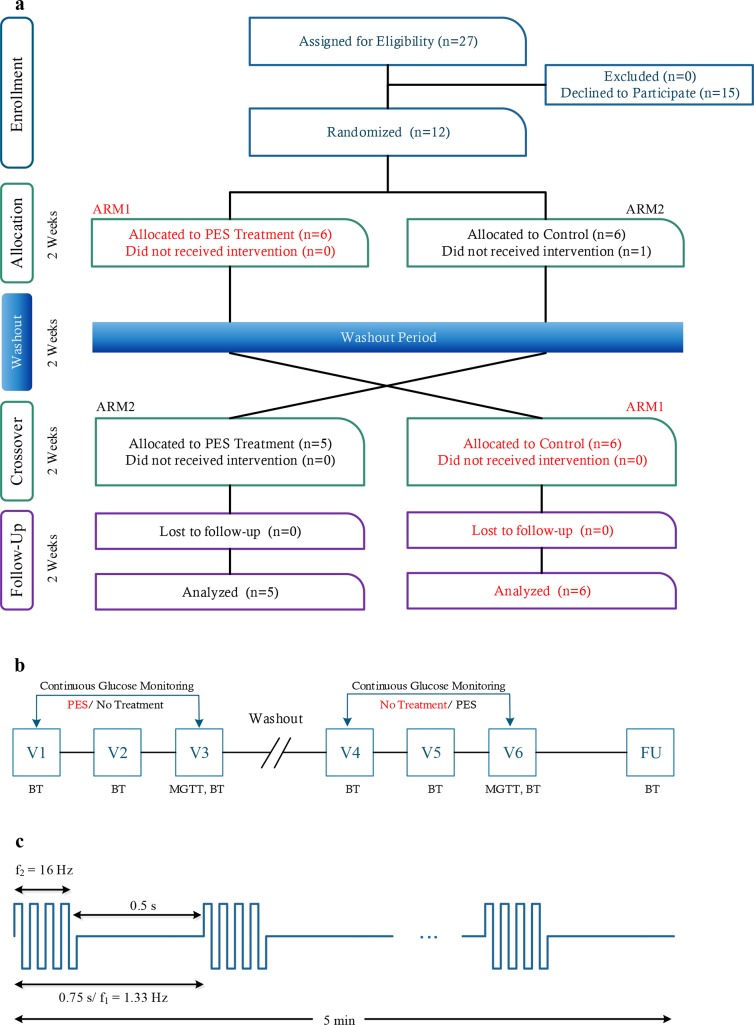
CONSORT flow chart and study design.a. A Crossover design with a two-week washout period separating each trial. b. Summary of study visits and procedures. PES–Home care peripheral electrical stimulation treatment, MGTT–meal glucose tolerance test. In visits V1-V6 and the follow up (FU) visit, all patients underwent a clinical evaluation, and BT (blood tests) were taken. c. PES signal treatment pattern.